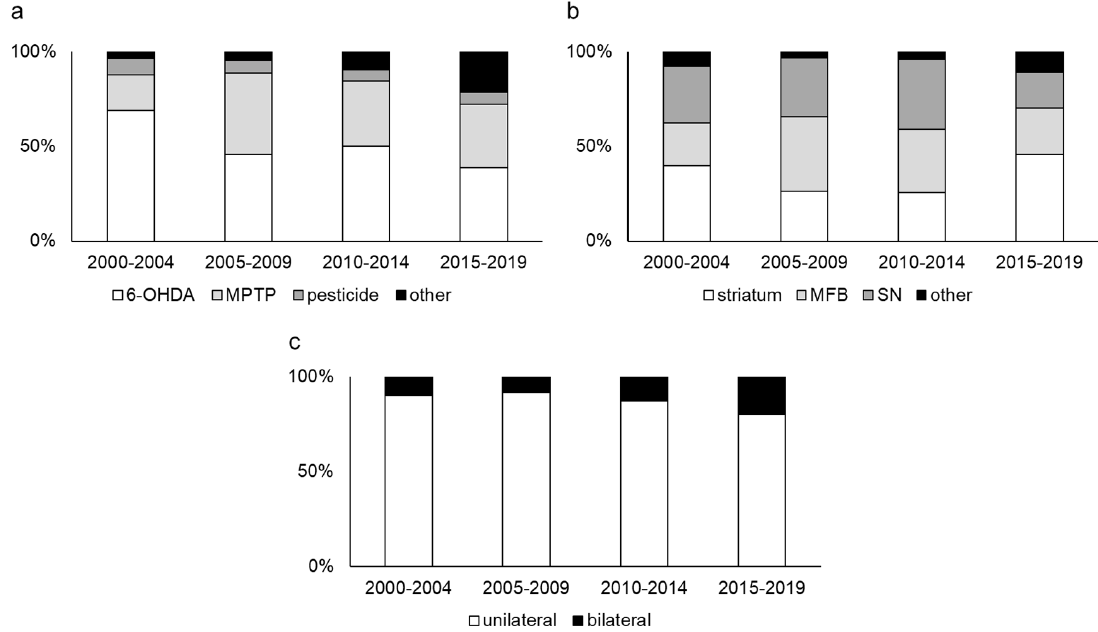
Figure 3. Neurotoxin model results. ( a ) The proportion based on the neurotoxin type. ( b ) The target proportion for 6-OHDA injection. ( c ) The proportion of unilateral or bilateral 6-OHDA injection.